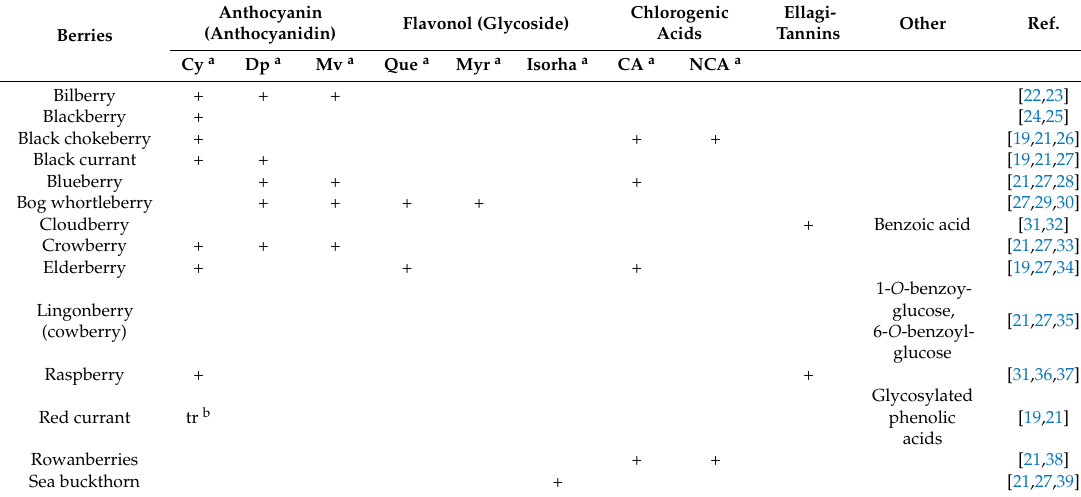
Table 2. Major phenolic compounds a in berry SPE extracts determined by 1